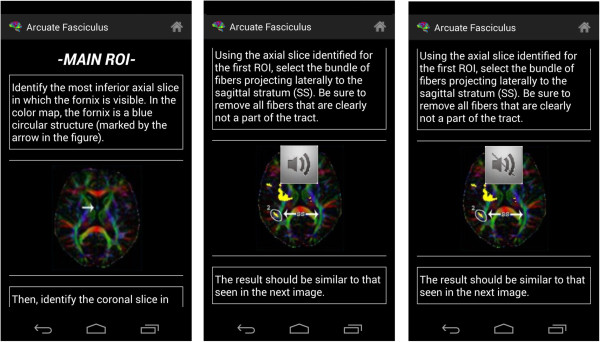
Region of Interest.